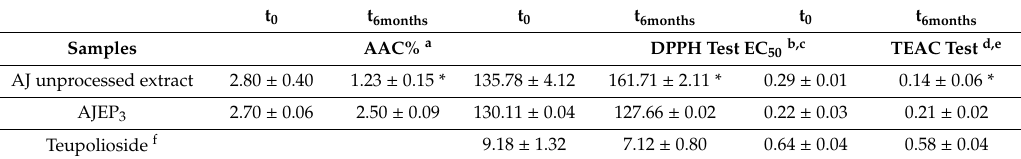
Table 2. Actual Active Content (%) and free-radical scavenging activity of extract before (AJ unprocessed extract) and after microencapsulation process (AJEP 3